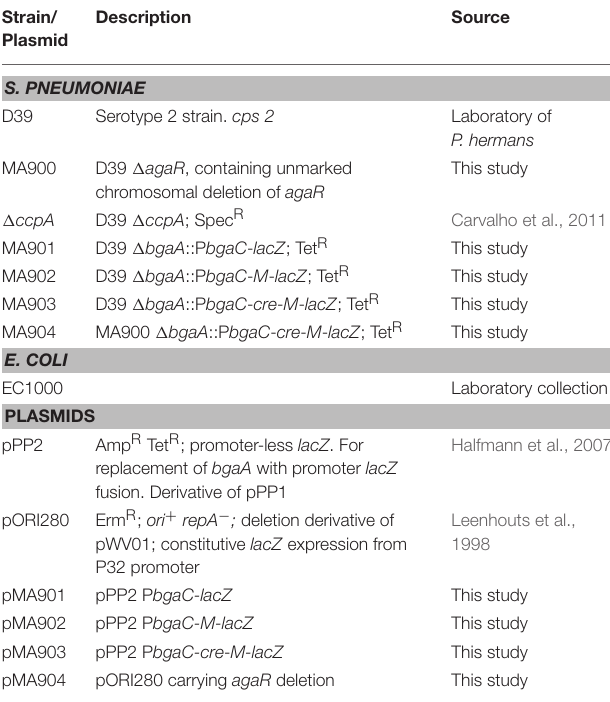
TABLE 1 | List of strains and plasmids used in this